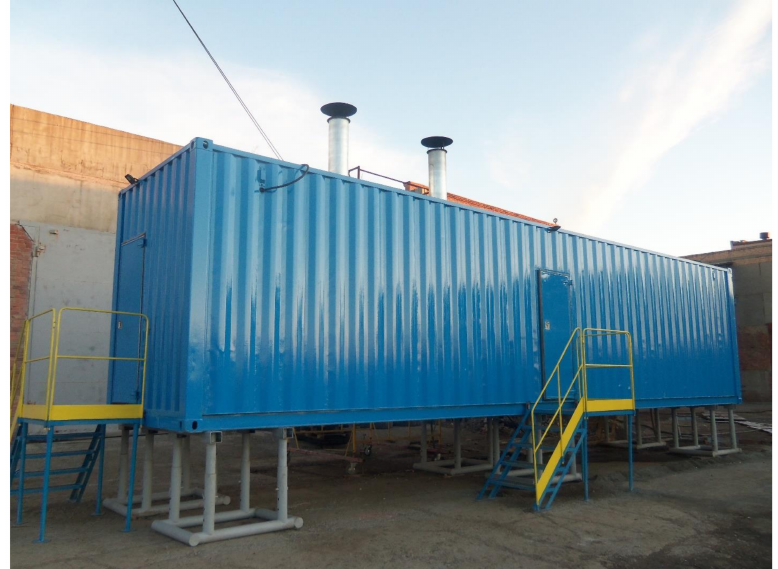
Figure 6. External view of a block-modular boiler house, with two coil-type steam generators installed inside, on which the research was carried